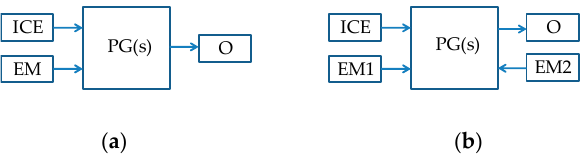
Figure 8. Classification of the PHPS: ( a ) PHPS with single EM; ( b ) PHPS with two EMs (O—output).